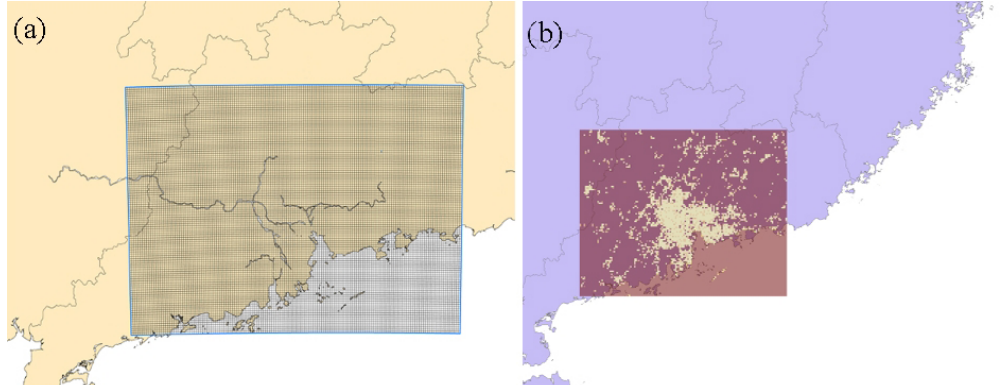
Figure 4. (a) Snapshot of D3 (3km) domain grids, and (b) calculated spatial surrogate.